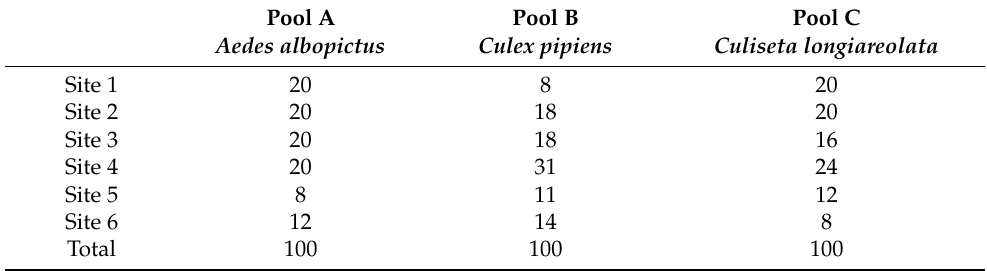
Table 1. Pools for virome